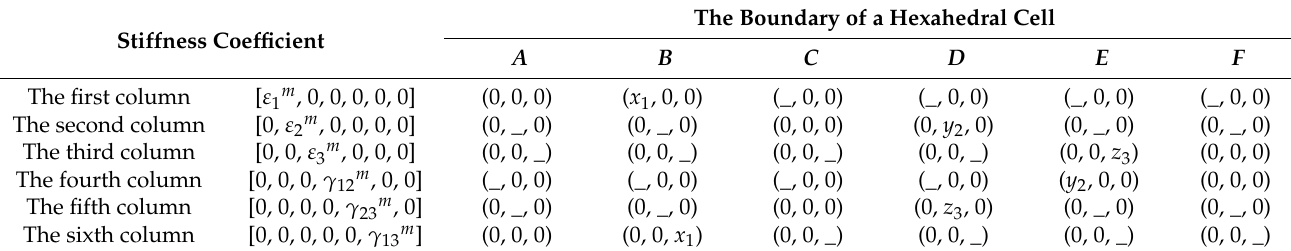
Table 1. Periodic displacement boundary